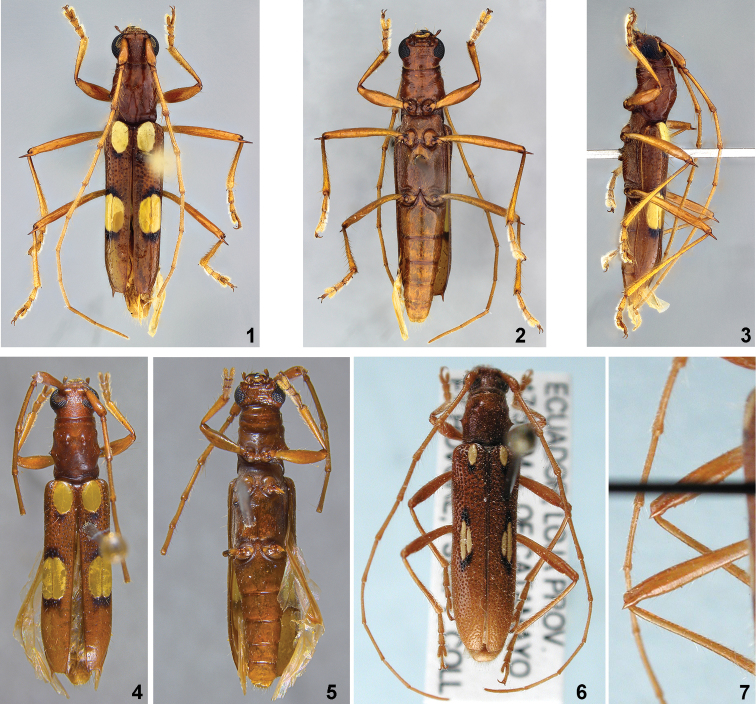
1–5Berabaanae sp. nov.: 1 dorsal view, holotype female 2 ventral view, holotype female 3 lateral view, holotype female 4 dorsal view, paratype male 5 ventral view, paratype male 6–7Berabaiuba Martins, 1997.